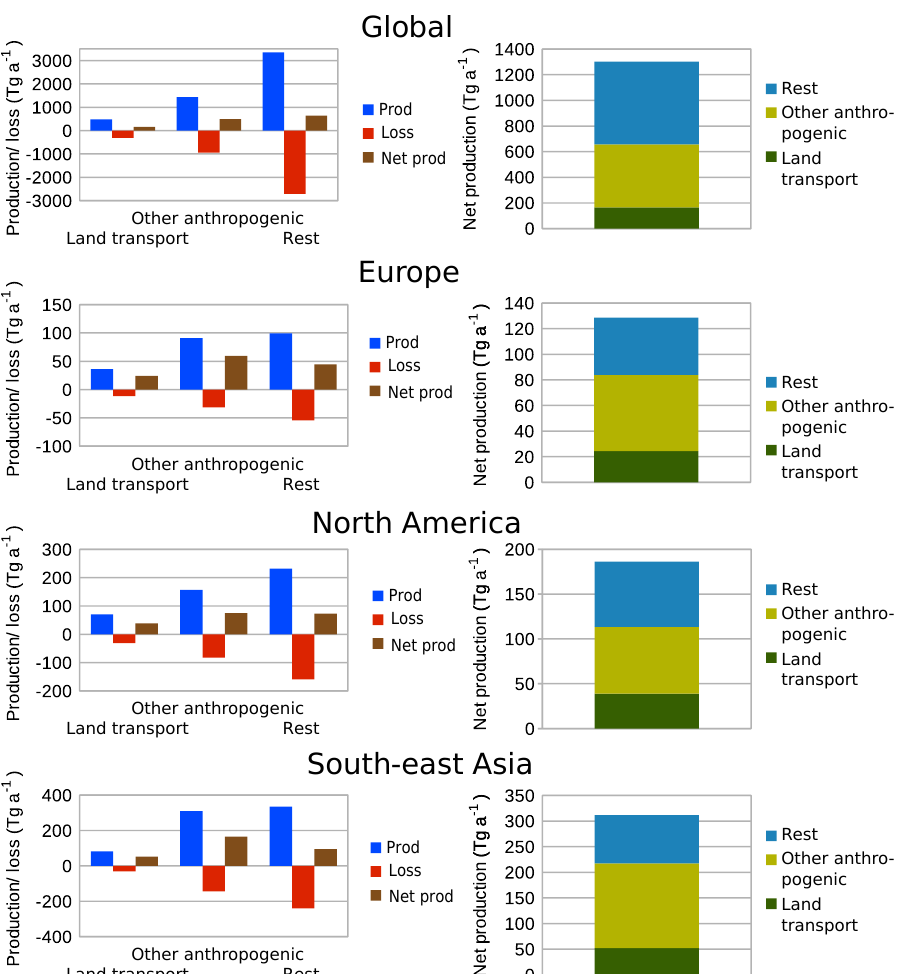
Figure 7. Production and loss rates of O 3 from different sectors (integrated up to 200hPa and averaged for 2006–2010). The left side shows the individual production and loss rates as well as the net O 3 production, while the right side shows only the net production of the different sectors. For simplicity only land transport, other anthropogenic (shipping, anthropogenic non-traffic, and aviation), and the rest (all other tagging categories) are